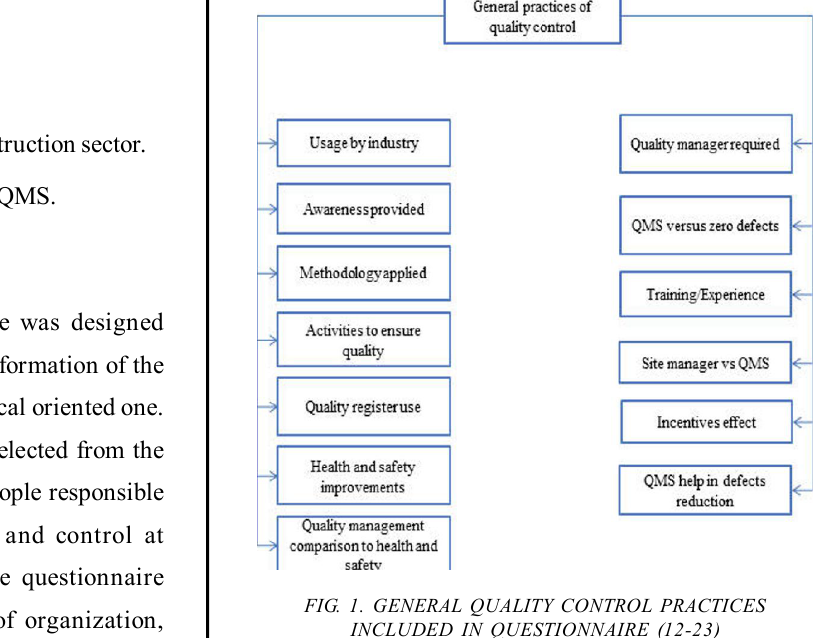
FIG. 1. GENERAL QUALITY CONTROL PRACTICES INCLUDED IN QUESTIONNAIRE